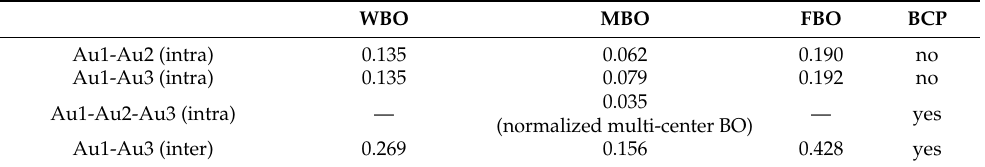
Table 2. Results of the BO analysis showing the results of different bonding indexes (WBO = Wiber bonding order, MBO = Mayer bonding order, FBO = Fuzzy bonding order, BCP = bond critical point).